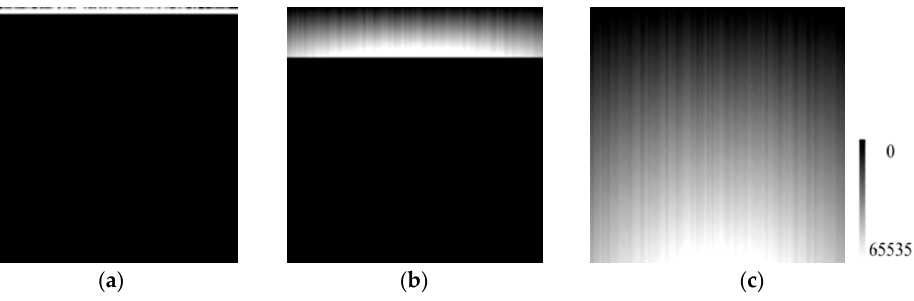
Figure 9. Simulated calibration data with different numbers of radiance level with the horizontal direction for the pixels and the vertical direction for the radiance level. The below black portions in ( a , b ) are filled with 0. ( a ) 3 radiance level; ( b ) 20 radiance level; and ( c ) 100 radiance level.